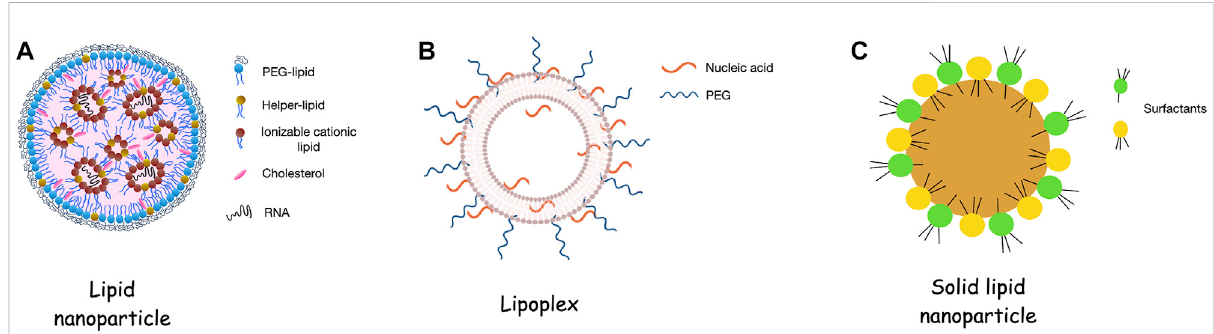
FIGURE 1 Consistency of lipidic nanoparticles for RNA delivery. (A) . Lipid nanoparticles (LNPs) contain an ionizable cationic lipid that allows the encapsulation of the RNA molecules into the internal aqueous cavities of the platform. Addition of PEG-lipid, helper lipid and cholesterol contribute in physicochemical and biological stability of the LNPs. (B) . Lipoplexes are liposomes that contain cationic lipids and are conjugated with nucleic acids i.e., RNA. IN this case the nucleic acids are mainly in the external surface of the systems leading which indicates that the RNA is more exposed to the environment than in the case of the LNPs. (C) . Solid lipid nanoparticles are formed by the lipid core of solid lipids and the amphiphilic surfactants that decorate the surface of the particles. Figure 1B adapted from Pereira et al.